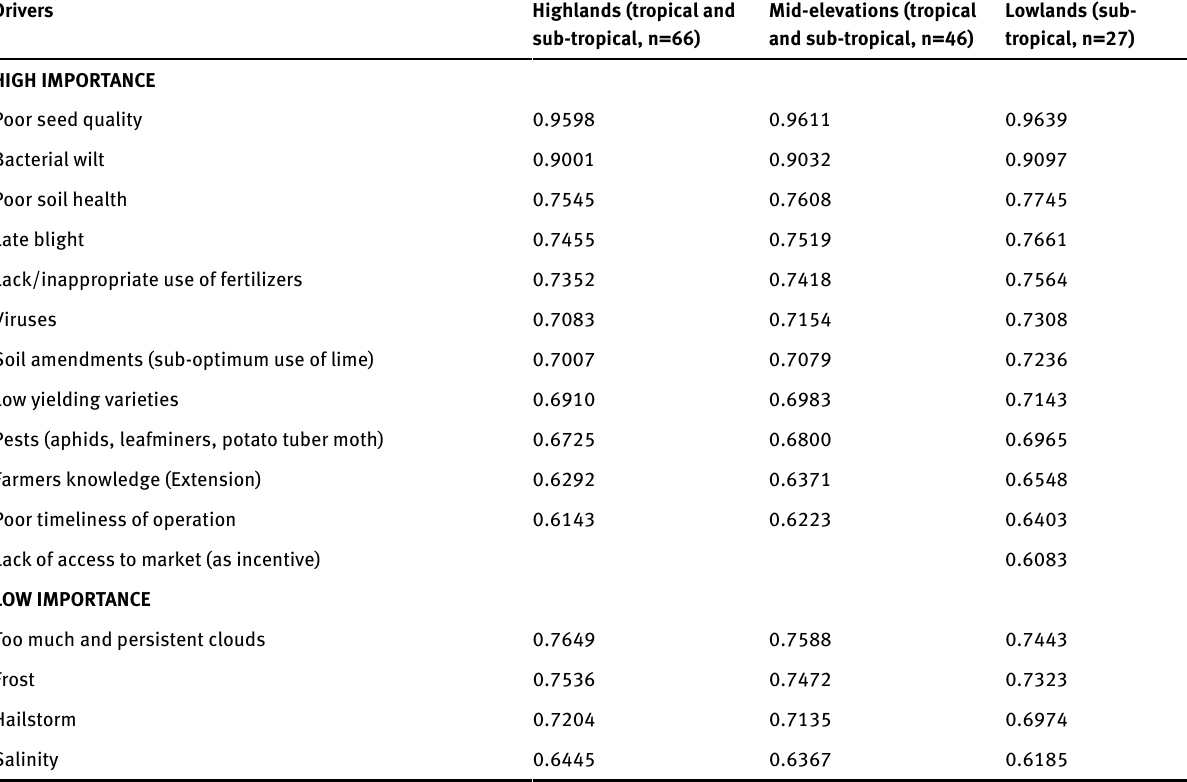
Table 2: Probabilities of highly important and less important potato yield gap drivers in SSA